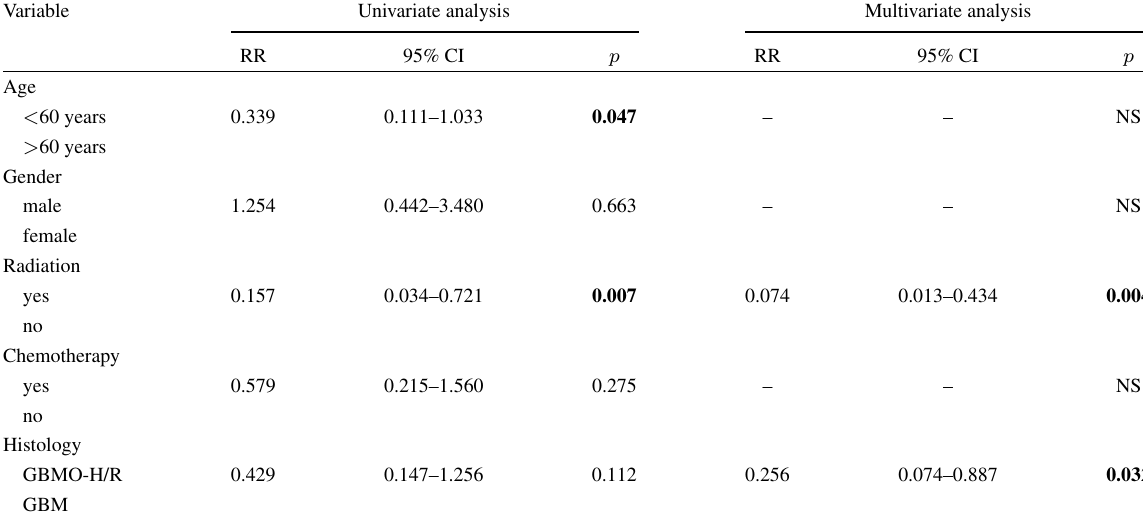
Univariate and multivariate analyses of clinicopathologic and histologic predictors of survival in GBM (13 GBMO and 10 GBM) Variable Univariate analysis Multivariate